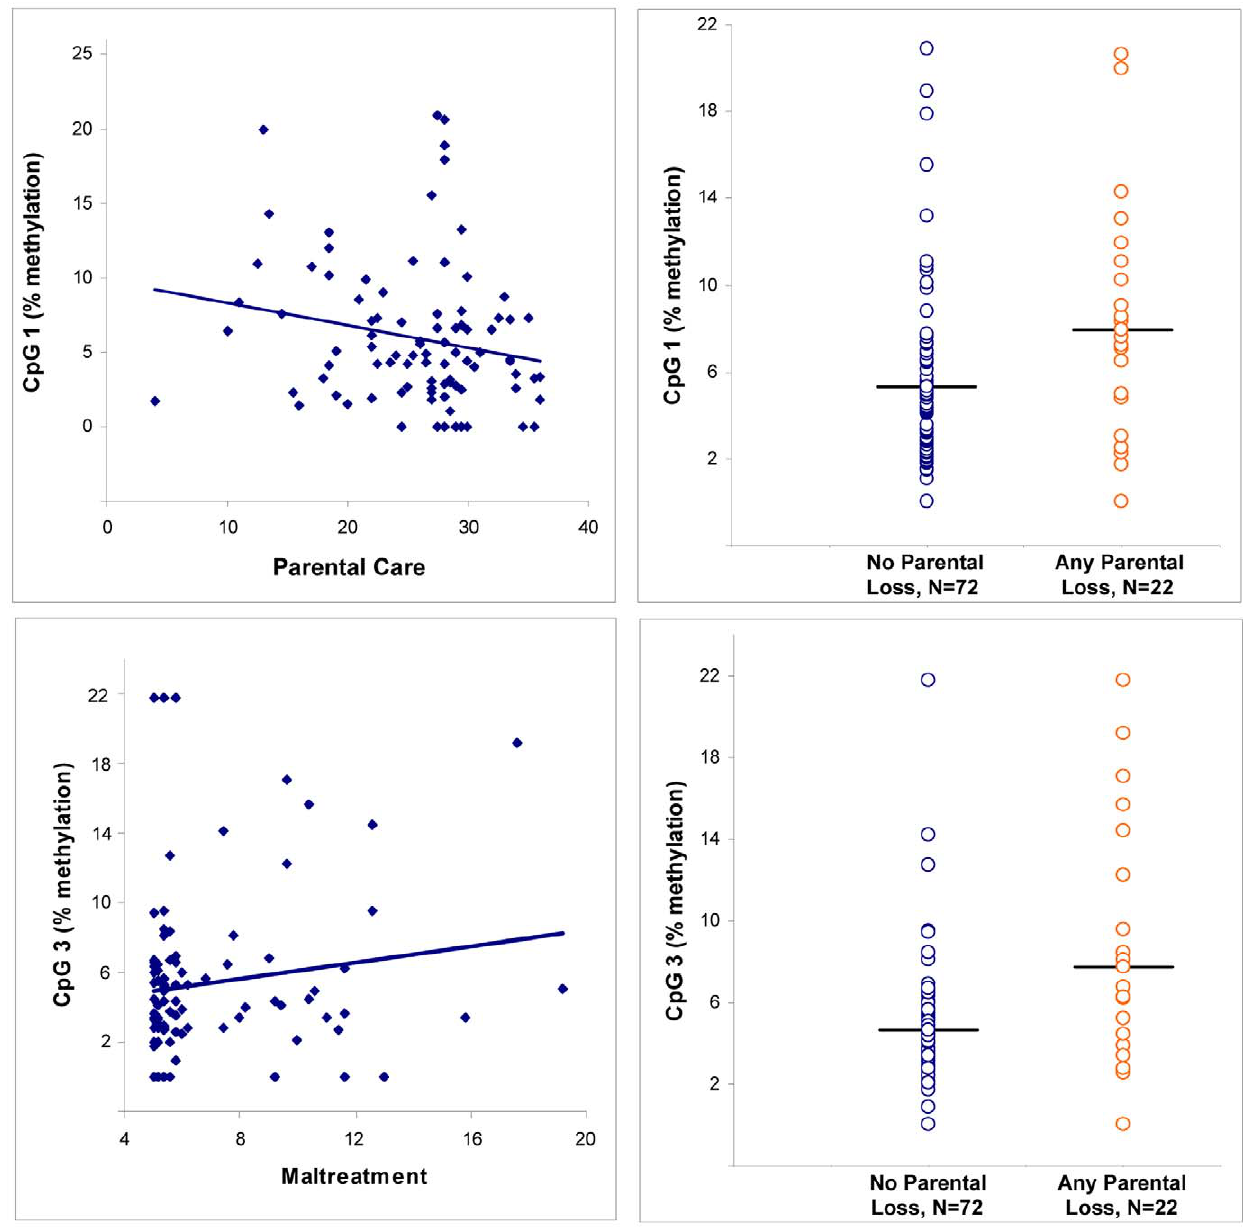
Figure 2. Significant Associations of Childhood Adversity Variables and Percent Methylation at Predicted CpG Sites (1–4). The Parental Care scale of the Parental Bonding Instrument reflects parental warmth, affection, and involvement; lower scores reflect greater parental coldness, rejection, and detachment. Maltreatment reflects the total score of Childhood Trauma Questionnaire. Parental loss is defined as loss of a parent before age 18, including death (N=12) and/or prolonged separation/desertion